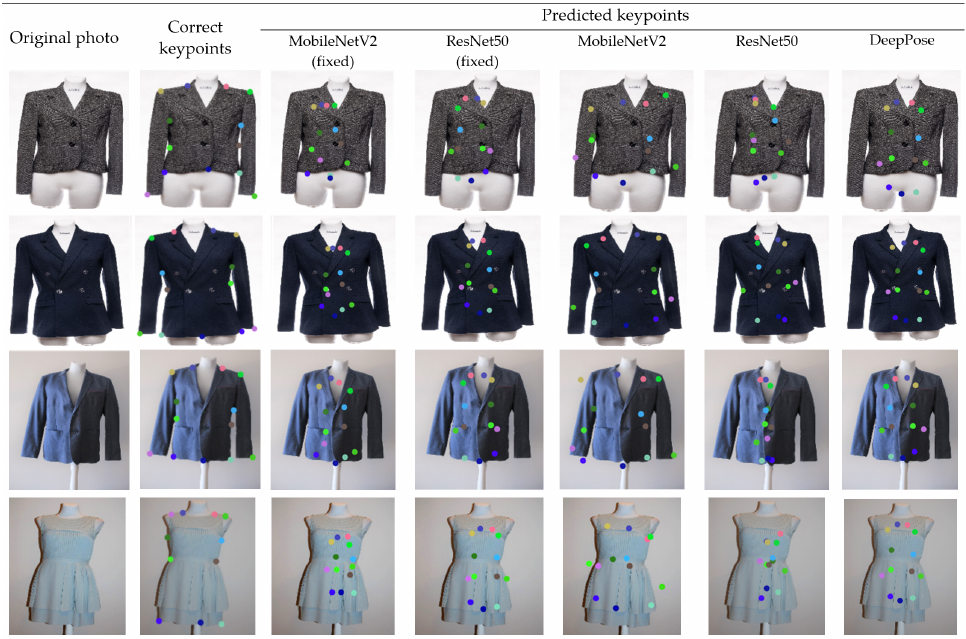
Figure 8. The comparison of different CNN architectures for keypoints